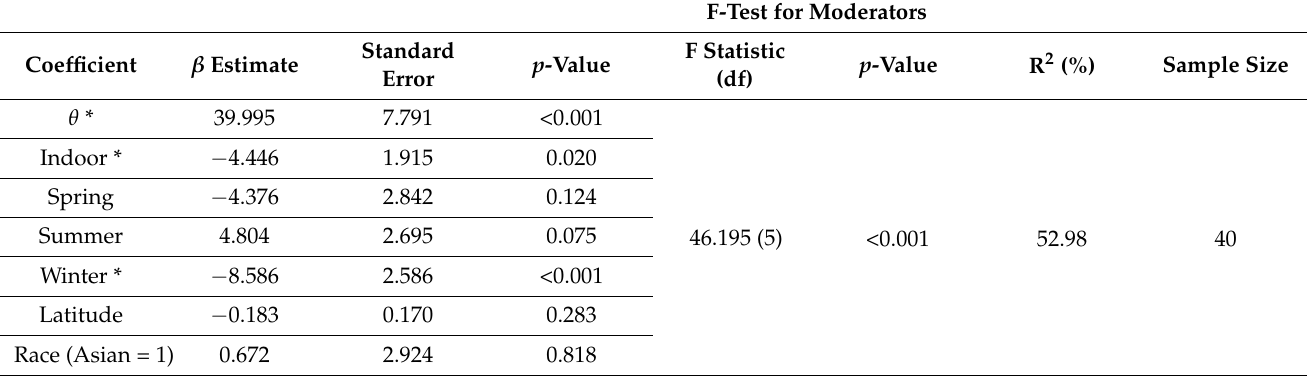
Table 5. Multivariate model investigating the significance of the type of sport, season, latitude, and Asian/Caucasian race as predictors of vitamin D levels. * = predictors with significant ( p < 0.05) β -coefficient. F-Test for